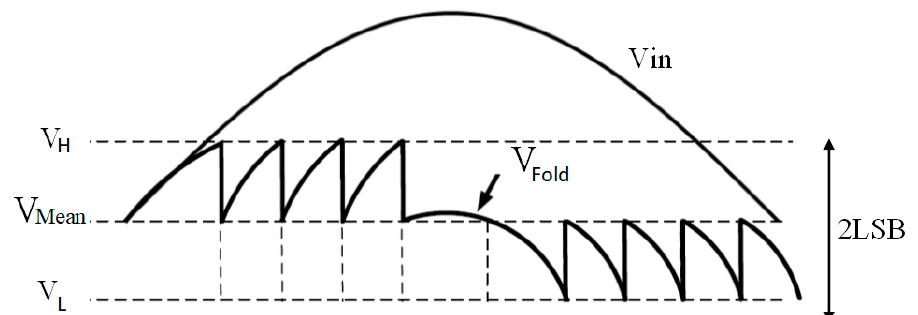
Figure 3. Operation of LC-ADC: K = 2 LSBs.